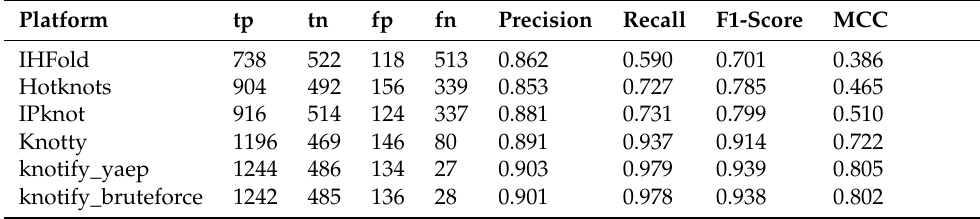
Table 6. Precision, Recall, F1-score, and MCC per platform for sequences of length < 30.